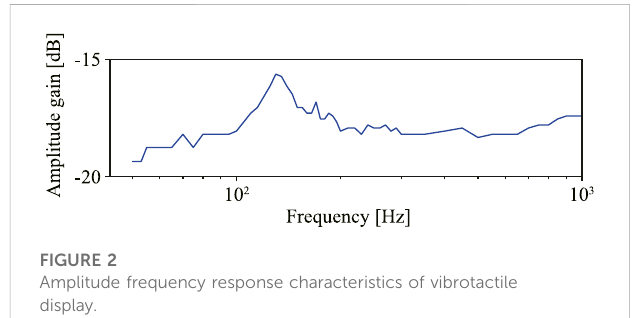
Amplitude frequency response characteristics of vibrotactile